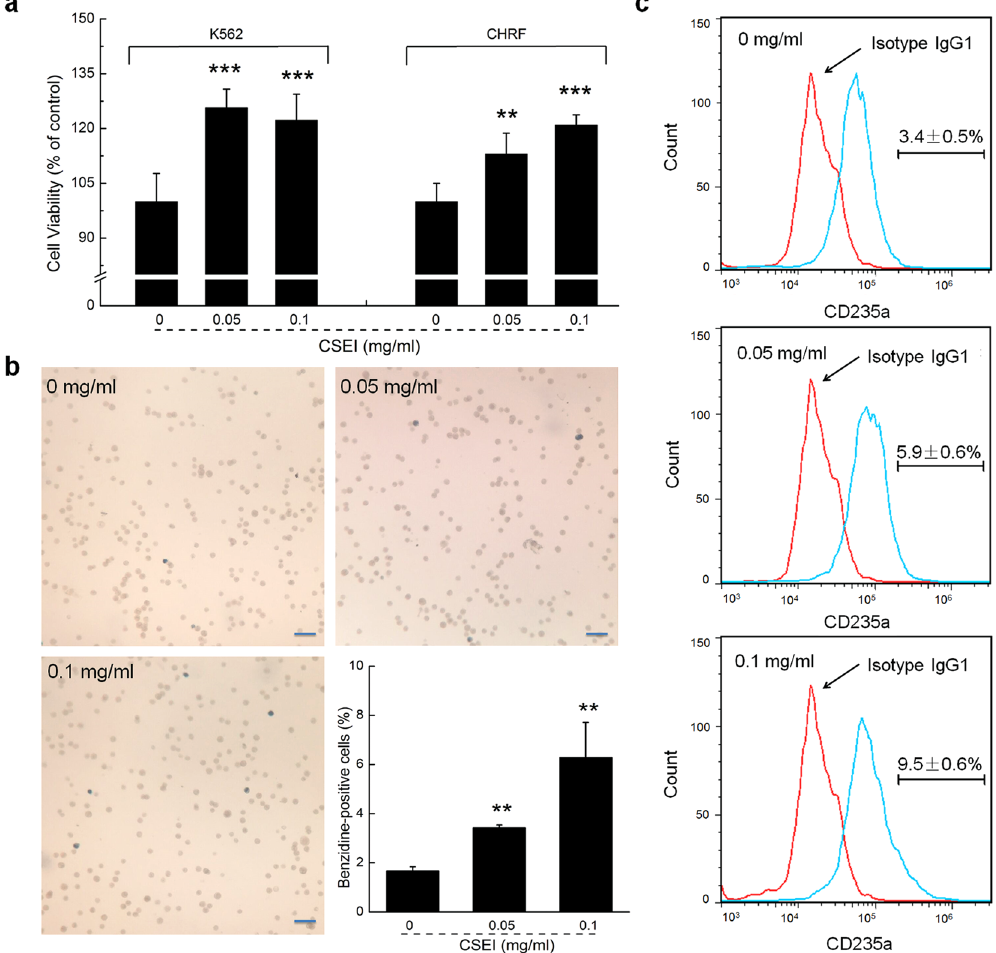
Figure 1. CSEI promoted proliferation and differentiation of CHRF and/or K562 cells. After a 24-h treatment of CSEI at doses of 0, 0.05 and 0.1 mg/ml, ( a ) cell viability of CHRF and K562 cells was detected by XTT assay, ( b ) the erythroid differentiation of K562 cells was analyzed by benzidine staining (10 × , scale bar: 100 μ m) and ( c ) the expression of glycophorin A (CD235a) in K562 cell line was analyzed by flow cytometry. Data are shown as the means ± S.E.M. (n = 6). ** P < 0.01 and *** P < 0.001 versus 0 mg/ml CSEI-treated